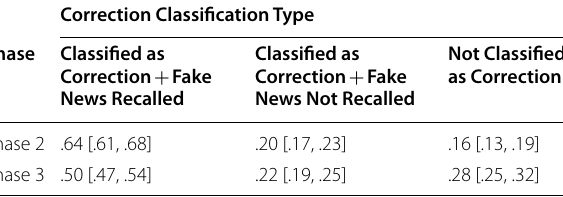
Table 2 Correction classification-type probabilities: Experiment